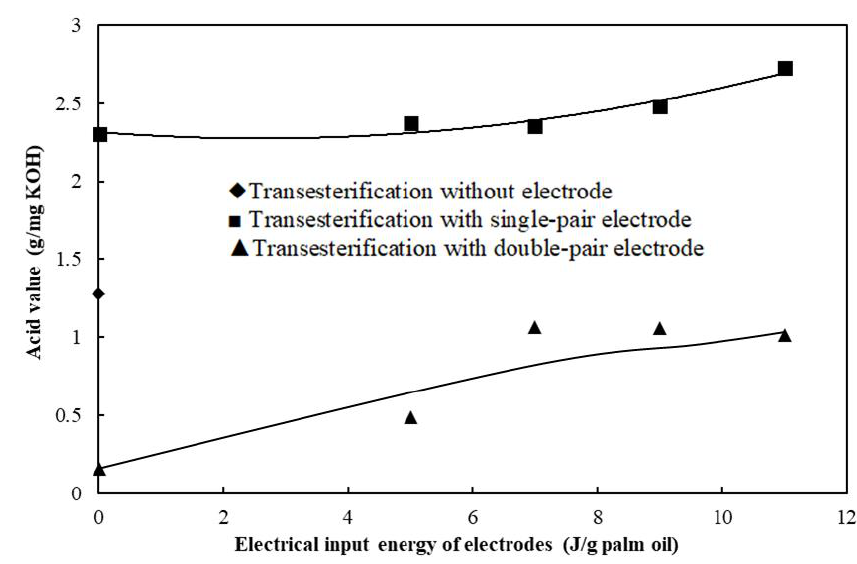
Figure 3. Effects of electrical energy input to electrodes for dissociating water on the acid value of biodiesel product.